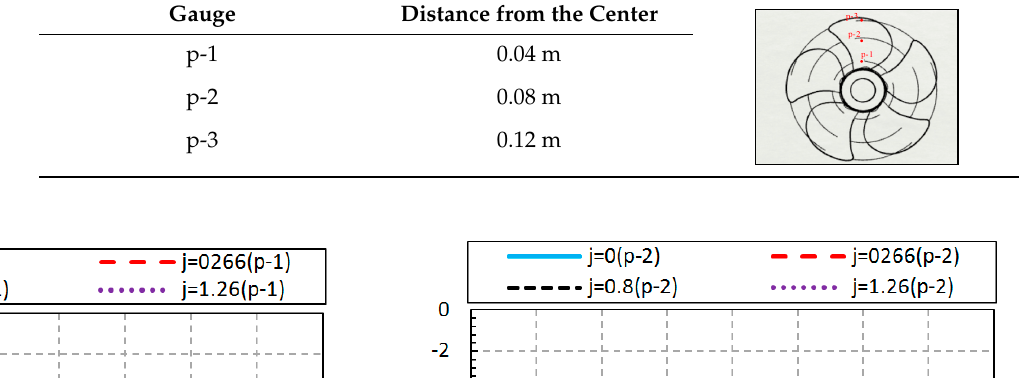
Table 6. Three gauge positions on the propeller blade.